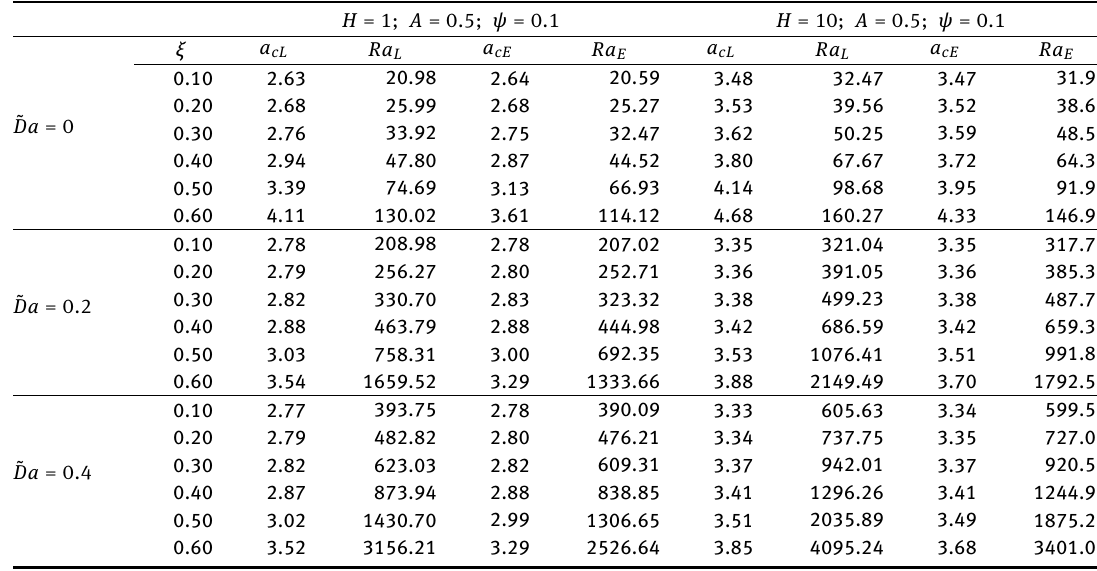
Table 4: Variation of critical Rayleigh number ( Ra L , Ra E ) with internal heat parameter ( ξ ) at fixed values of ˜ Da , H , A , ψ for case C of decreasing heat source